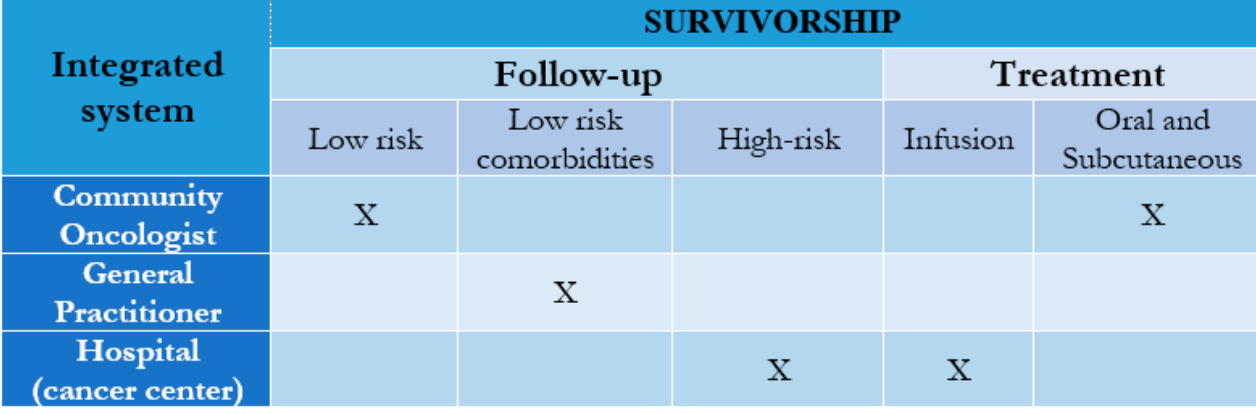
Figure 2. Model of follow-up and treatment according to cancer- and comorbidity-related risk and type of treatment.